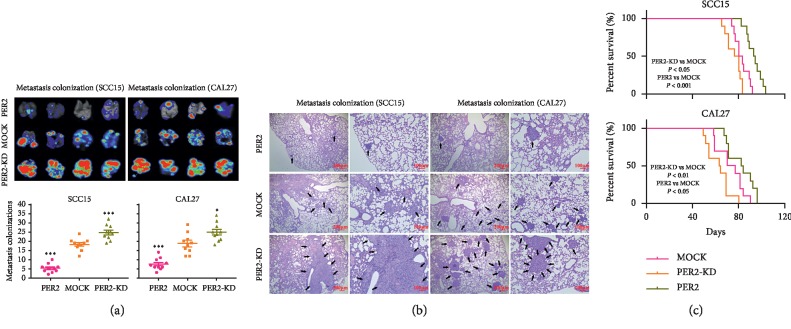
PER2 inhibits tumor metastasis and improves the prognosis of OSCC cells. (a and b) Cells were transported into mice with an injection of caudal veins and lung tissues were obtained later. Metastasis colonization of lung tissues from OSCC cells was detected by in vivo fluorescence imaging (a) and H&E staining (b). (c) The prognosis of metastasis models was depicted by the Kaplan–Meier curves. ∗P < 0.05, ∗∗∗P < 0.001.